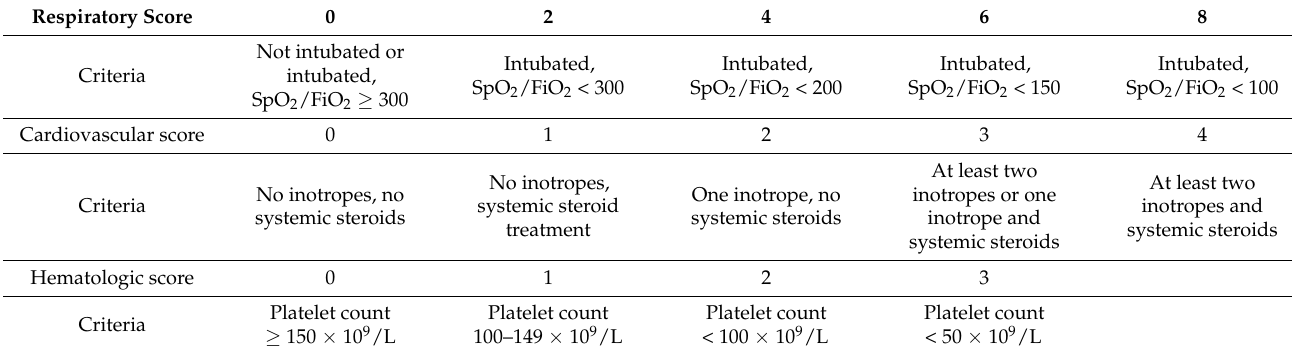
Table 1. Neonatal sequential organ failure assessment score